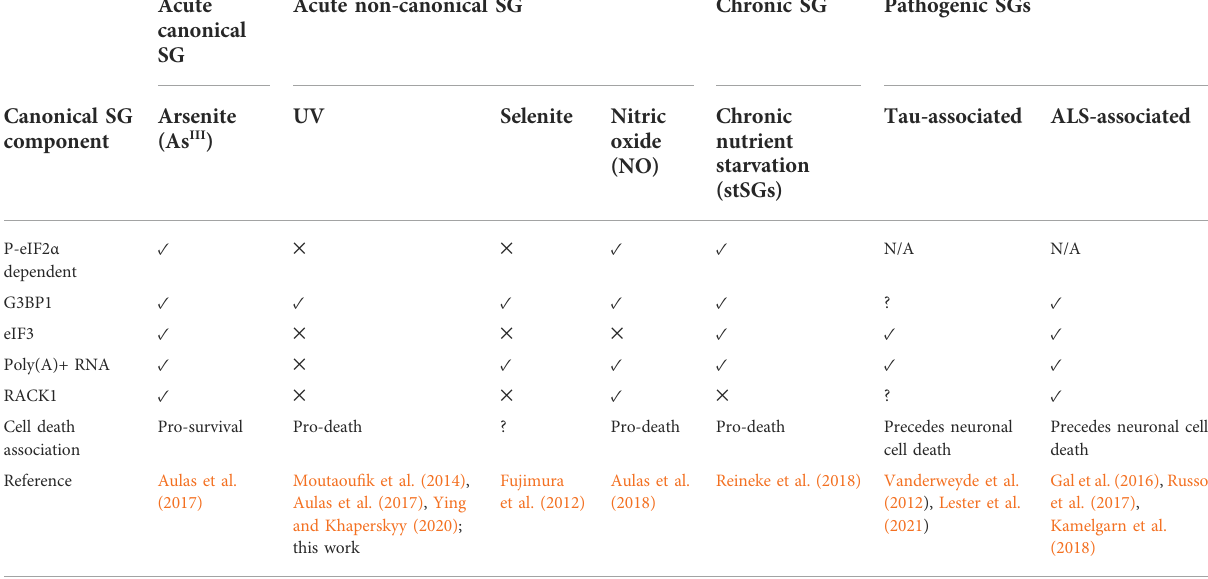
TABLE 1 A comparison of key features of canonical, non-canonical, chronic, and pathogenic SG